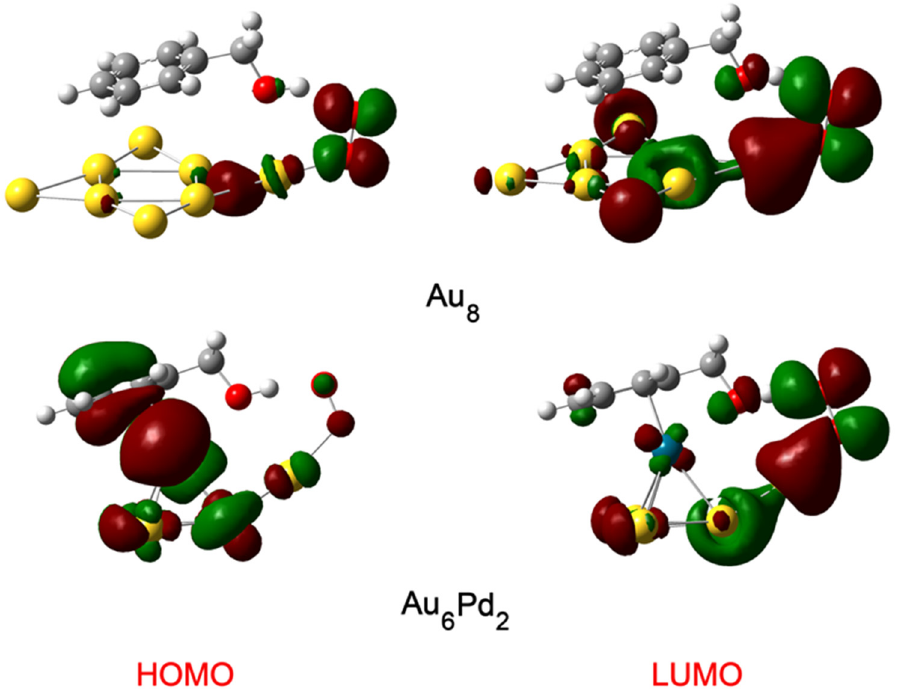
Figure 4. Frontier orbitals of the adsorption complex of Au 8 and Au 6 Pd 2 with benzyl alcohol and O 2 .